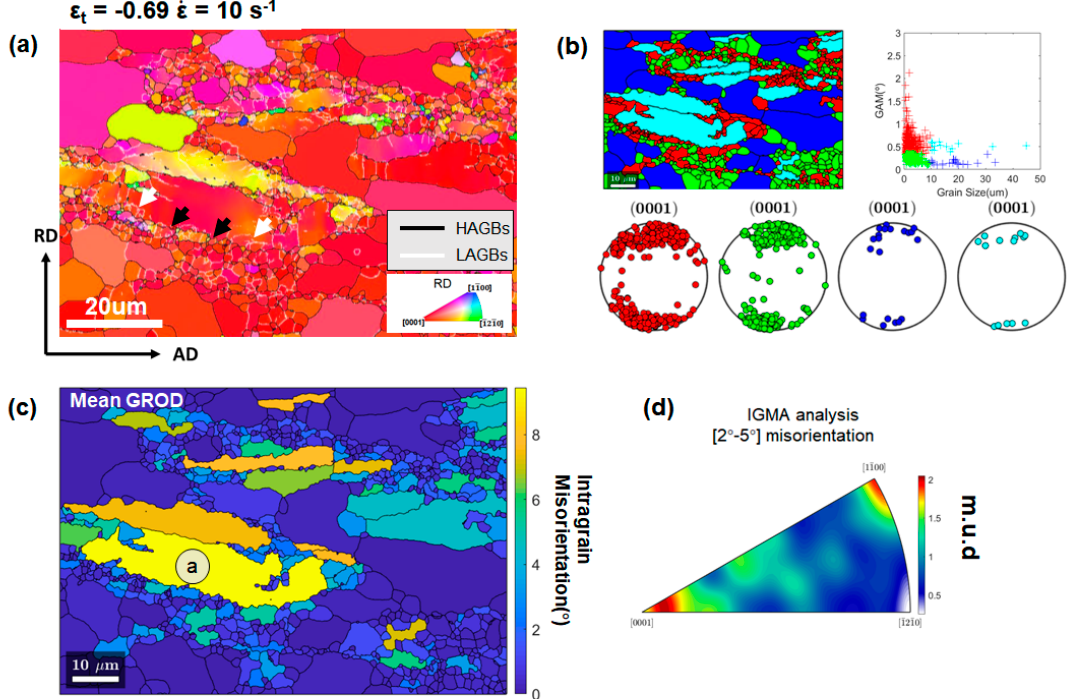
Figure 13. ( a ) IPF map of the microstructure deformed to ε t of − 0.69 at of 10 s − 1 with a step size of 0.12 µ m. White arrows indicate sub-grains, and black arrows indicate grain boundary corrugations. ( b ) Grain partitioning map on the basis of the GAM value and grain size. Grains were divided into a red / green / blue / cyan color scheme with the corresponding pole figures shown at the bottom, ( c ) mean GROD map, ( d ) IGMA analysis of the sheared coarse grain labeled ‘a’ in ( c ).